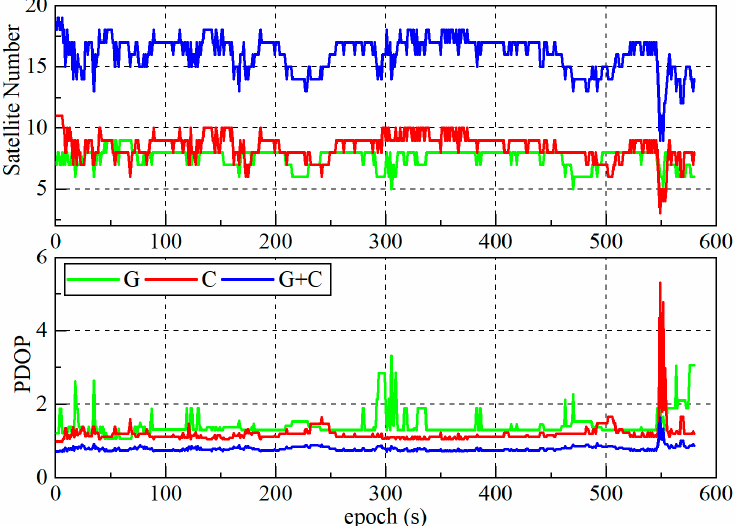
Figure 4. The number of visible satellites and position dilution of precision (PDOP) for single GPS (G), single BDS (C), and their combination (G + C).